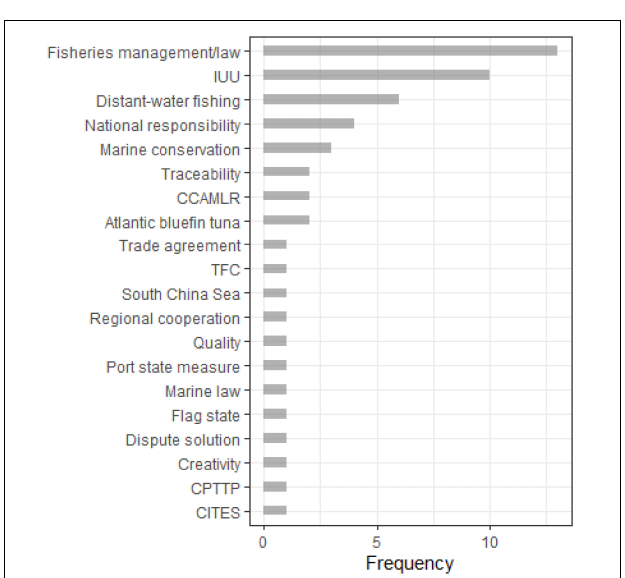
FIGURE 2 | Illustration of keyword frequency in surveyed Chinese and English scholarly literature. CCAMLR, Commission for the Conservation of Antarctic Marine Living Resources; TFC, Transferable Fishing Concessions; CPTTP, Comprehensive and Progressive Agreement for Trans-Pacific Partnership; CITES, Convention on International Trade in Endangered Species of Wild Fauna and